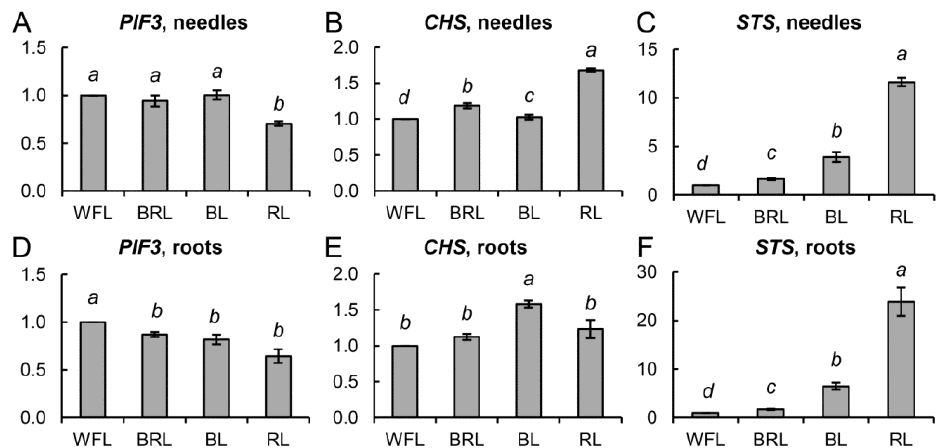
Figure 5. Effect of light quality on the transcript levels of different groups of genes in P. sylvestris seedlings. PIF3, CHS, and STS in needles( A – C ), and roots ( D – E ). The mRNA levels of the genes were expressed as the BRL, BL, RL/WFL ratio (fold change BRL, BL, RL/WFL). Different italic letters denote statistically significant differences in the means at p < 0.05 (Kruskal – Wallis ANOVA of the ranks followed by the Student-Newman – Keuls post hoc test).